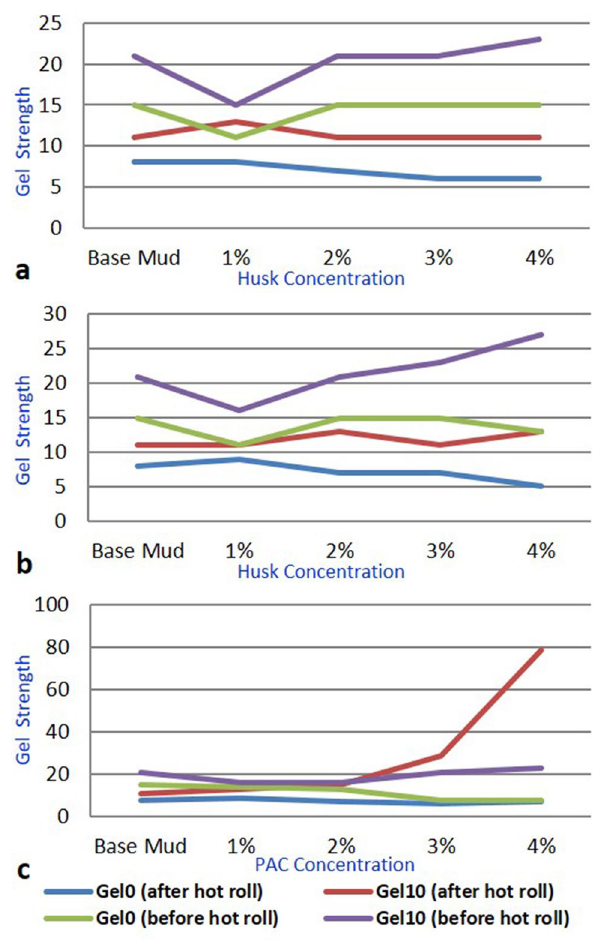
Fig. 9 Gel strength comparison of developed drilling fluid formula- tions before and after hot roll a 250–297 µm, b 63–74 µm, c